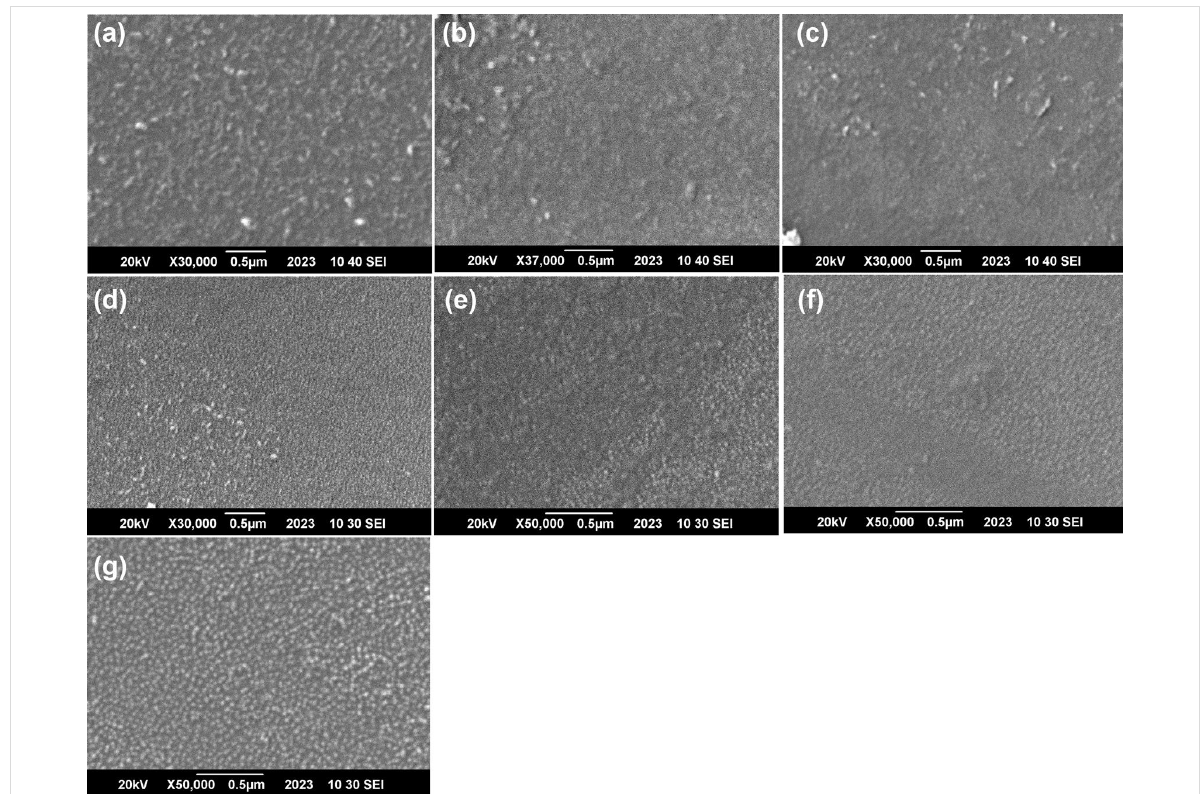
Figure 1: SEM images of the different zinc oxide nanoparticles. (a) ZnO, (b) ZnO:Ag (1%), (c) ZnO:Ag (3%), (d) ZnO:Ag (5%), (e) ZnO:Ag (10%), (f) ZnO:Ag (20%), and (g) ZnO:Ag (30%).